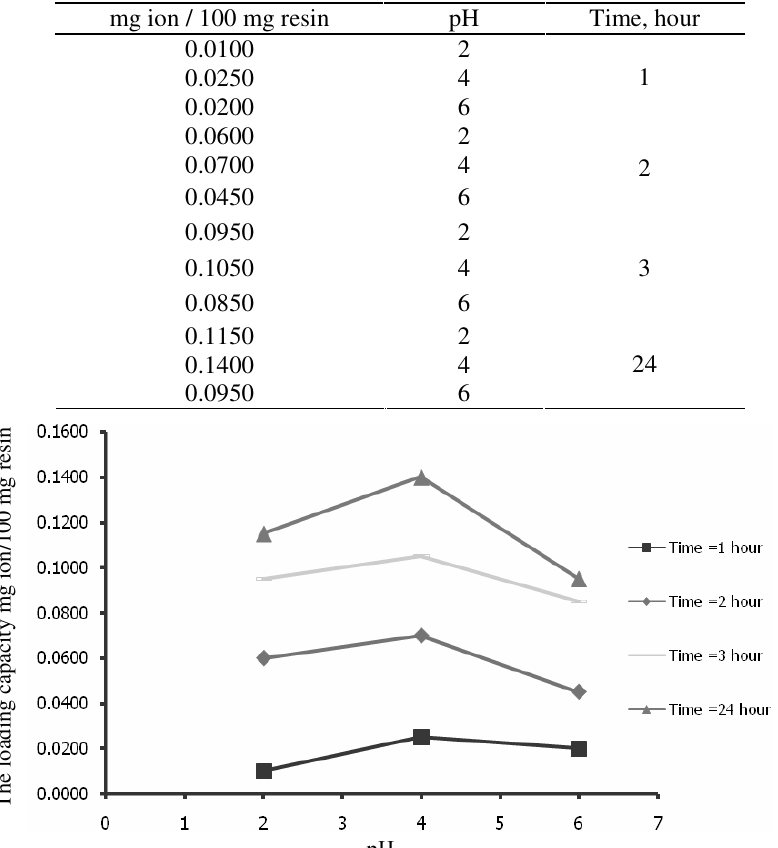
Table 5. The effect of pH on the loading capacity for Ni(II) ions.